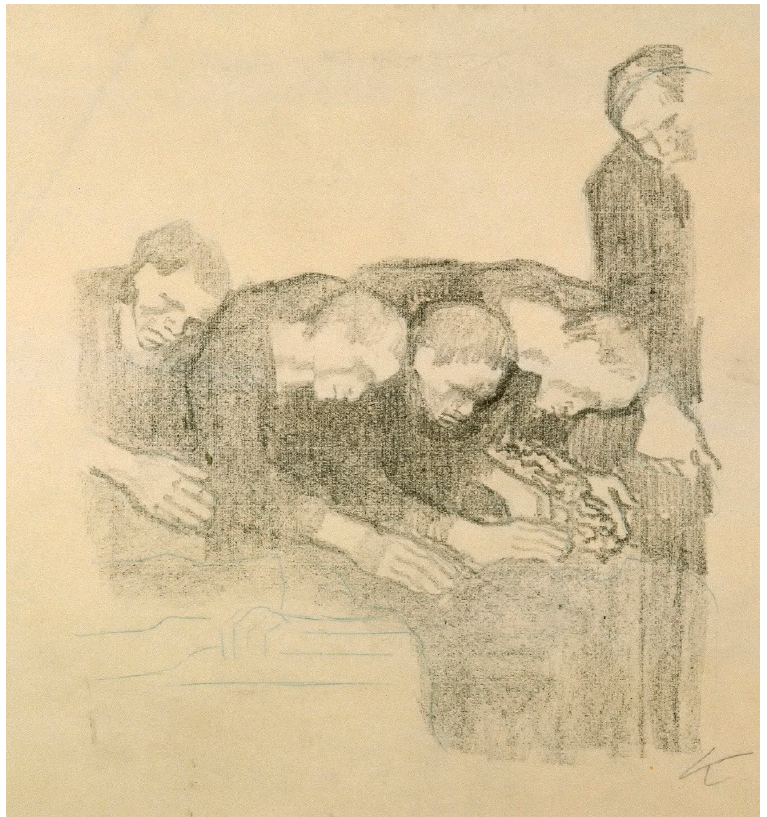
Figure 3. Käthe Kollwitz, In Memory of Ludwig Franks [Dem Andenken Ludwig Franks], rejected second version, 1914. Chalk lithograph (from an unknown drawing on laid paper), 33.7 cm × 30.6 cm. Kn 131, Kölner Kollwitz-Sammlung © Käthe Kollwitz Museum Köln.